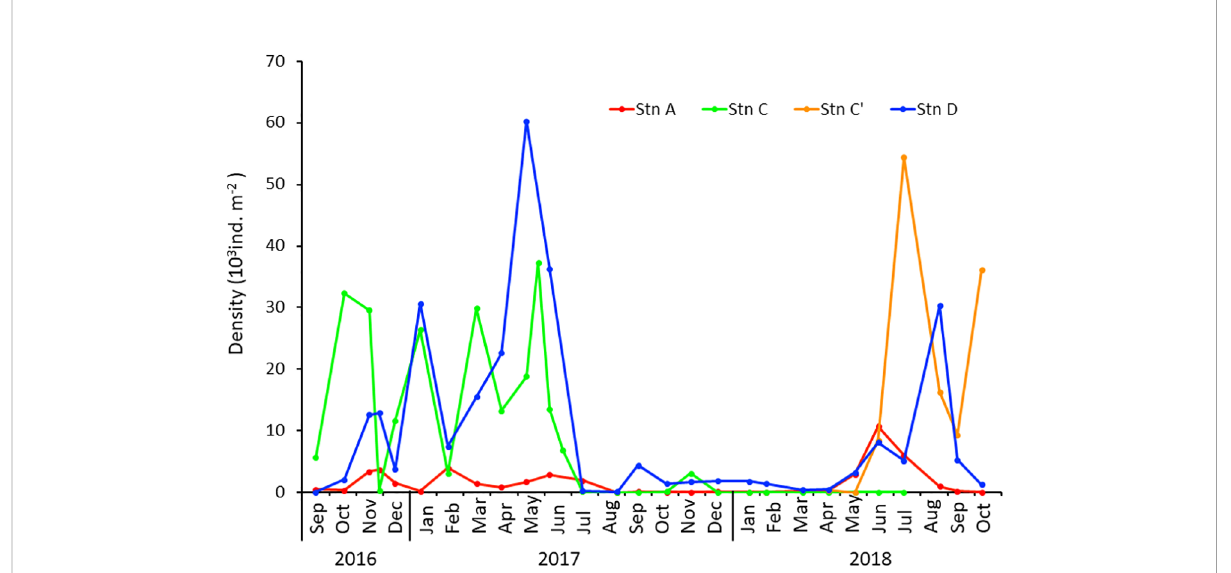
FIGURE 4 Seasonal changes in the density of Capitella aff. teleta at Stns A, C (and C ′ ), and D in Gamo Lagoon from September 2016 to October